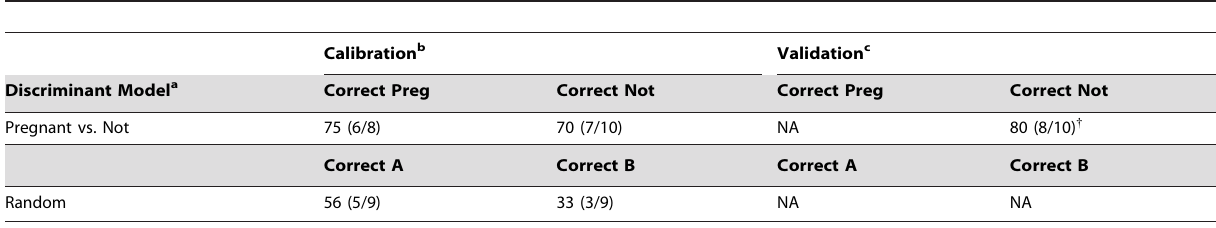
Table 6. Application of near infrared spectroscopy of feces to discriminate between pregnant and not pregnant female captive giant pandas ( Ailuropoda melanoleuca ) housed in US zoos.